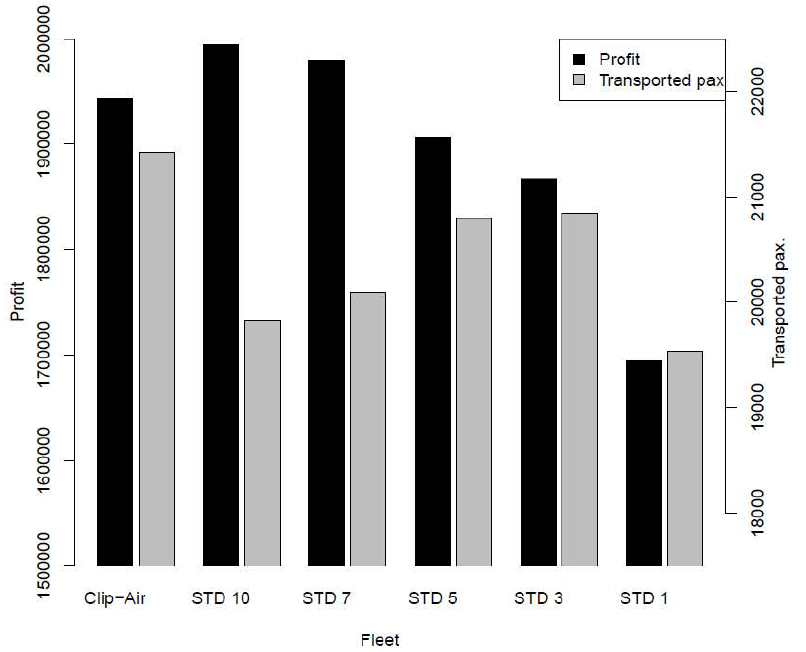
Figure 4. Profit and transported passengers for different fleet